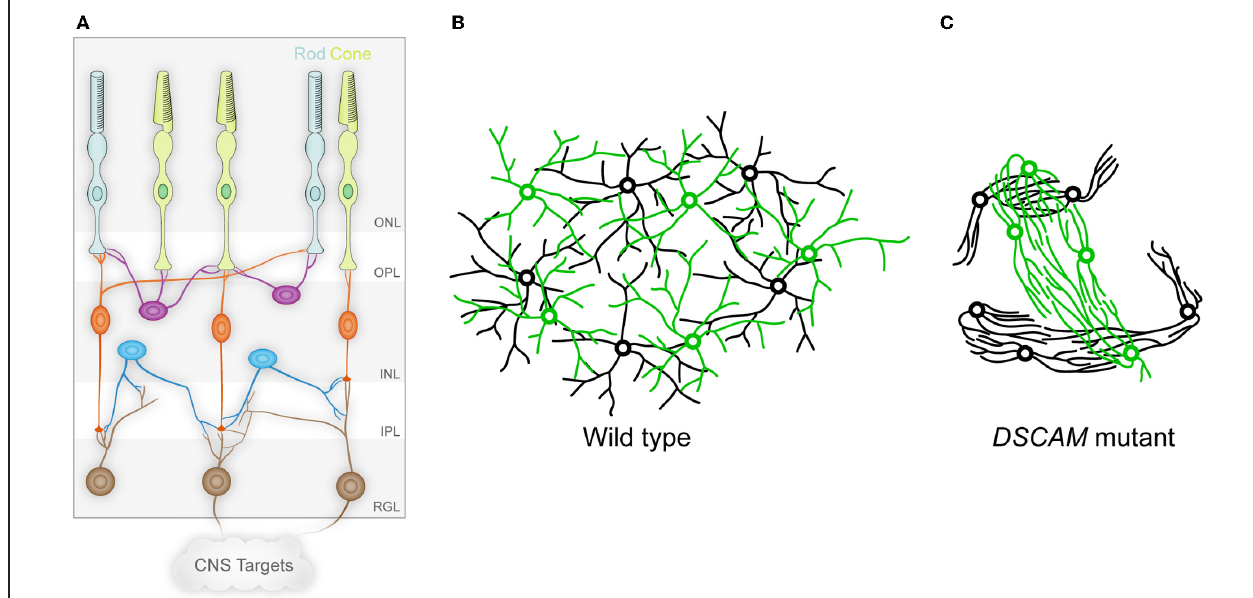
FIGURE 1 | The vertebrate retina and DSCAM in self-avoidance. (A) The vertebrate retina is organized in columnar microcircuits connecting rod and cone photoreceptors in the outer nuclear layer (ONL) to horizontal (purple), bipolar (orange), and amacrine (blue) interneurons in the inner nuclear layer (INL) by synapses formed in the outer plexiform layer (OPL). The interneurons in turn form synapses in the inner plexiform layer (IPL) onto the dendrites of ganglion cells in the retinal ganglion cell layer (RGL), which project axons to the brain through the optic nerve. Establishing this anatomy involves both vertical organization into the different layers, and horizontal organization in which cells of a given type are non-randomly spaced and their dendritic